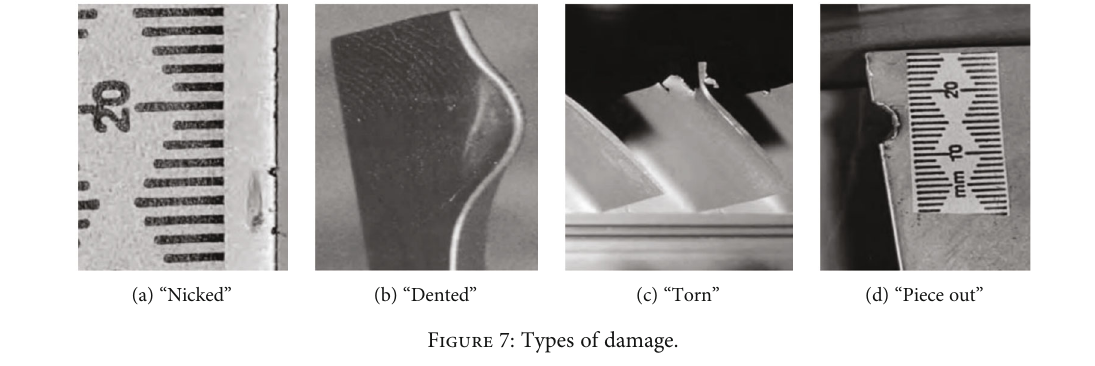
Figure 7: Types of damage.